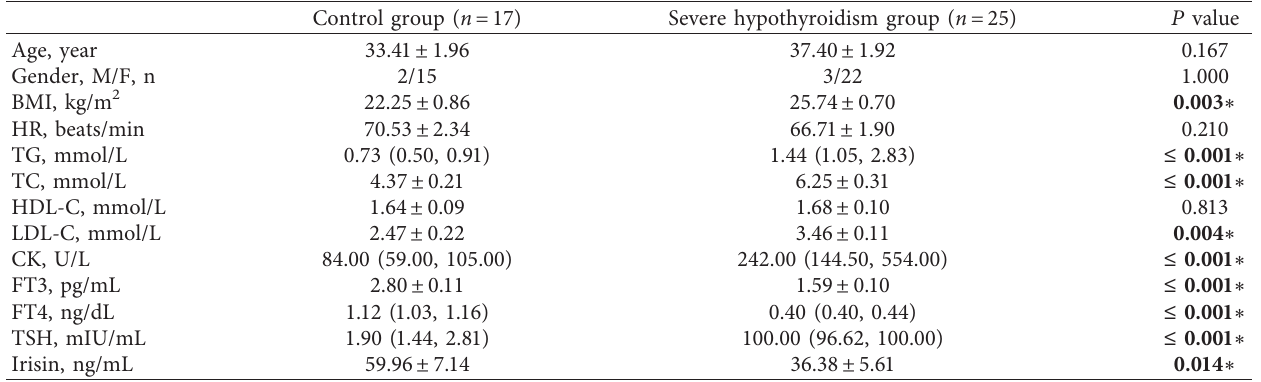
Table 1: Baseline characteristics of control and severe hypothyroidism